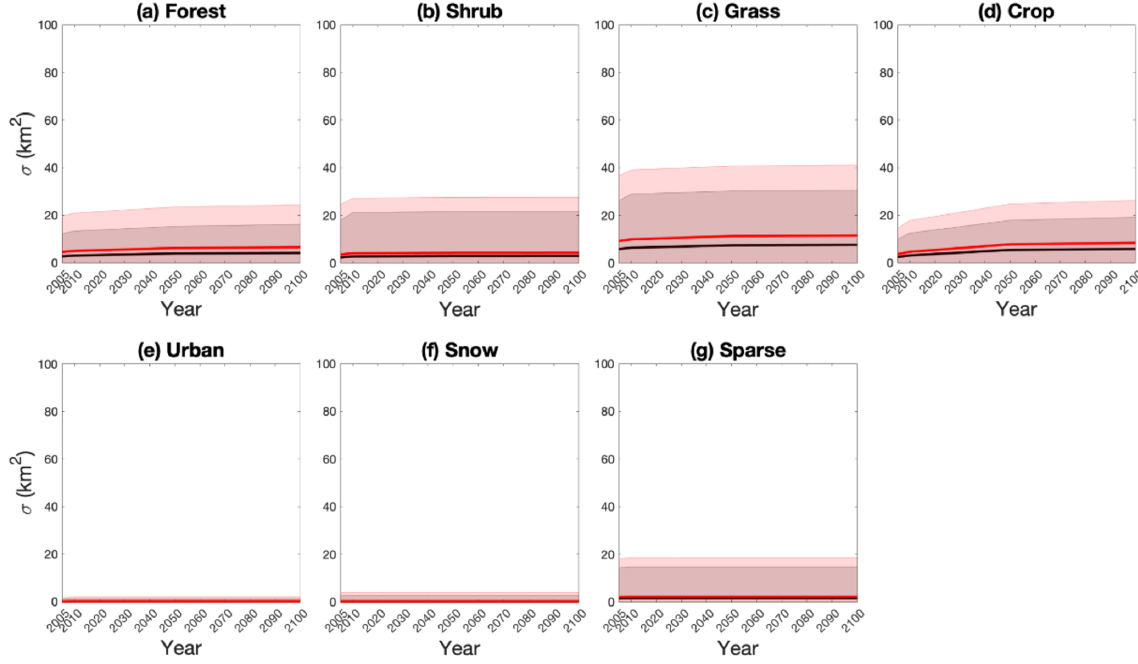
Figure 8. The mean (shown as the solid lines) and standard deviations ( σ , shown as the shaded area) for the downscaled final land type (FLT) areas when propagating the parameter uncertainties into the GCAM-projected land use and land cover change downscaling in the 21st century. The black and red colors represent using the top 5% and 10% parameters,